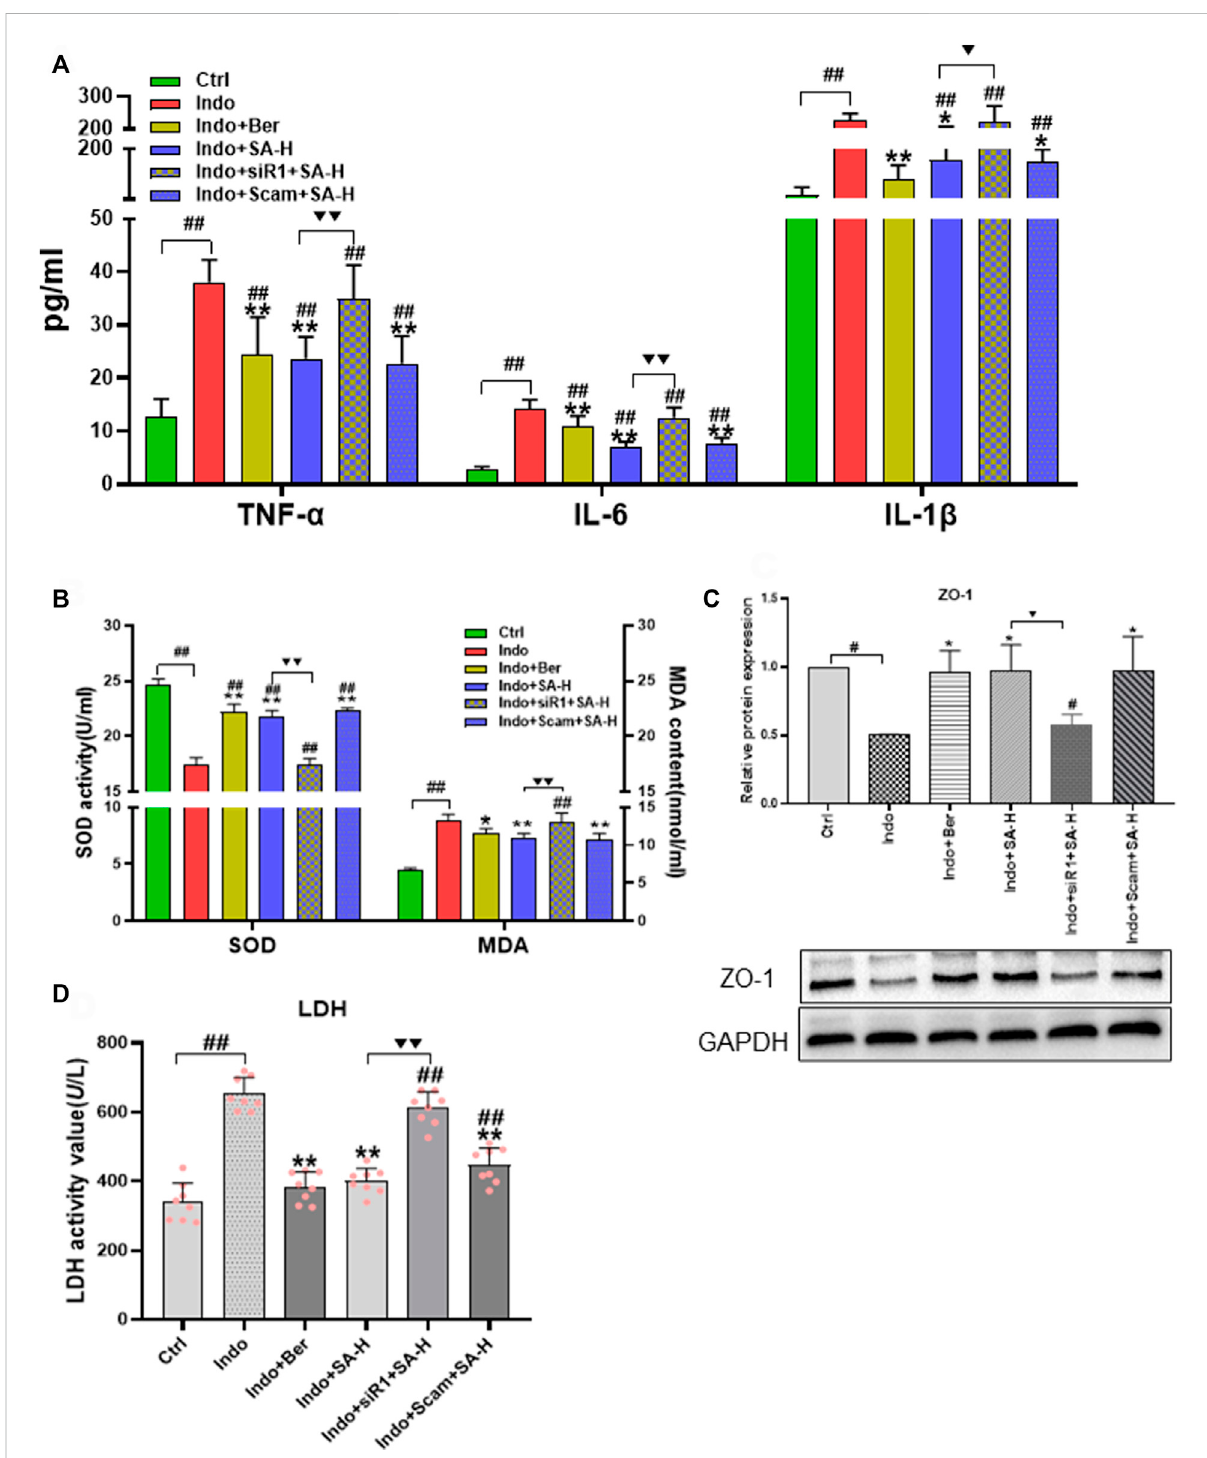
FIGURE 9 EffectsofNrf2silencingontheexpressionofZO-1,levelsofLDH,in fl ammatoryfactors,SODactivityandMDAcontentofIEC-6cellsinducedby indomethacin. IEC-6 cells were treated with indomethacin (Indo, 300 μ mol L − 1 ) and/or sanguinarine (SA, 1.0 μ mol L − 1 , SA-H) or with berberine (Ber, 30 mmol L − 1 ). (A) In fl ammatorycytokines.TNF- α ( left ),IL-6( middle ),andIL-1 β ( right )weremeasuredbyELISA( n =9). (B) Oxidativestressparameters of MDA and SOD were detected using a colorimetric assay kit and a chemiluminescent assay kit, respectively ( n = 6). (C) Protein levels of ZO-1 evaluated bywestern blot( n =3). (D) LDH releasedfrom theIEC-6cells, measuredbychemiluminescence ( n =8).Data are presented asthemean ± SD. # p < 0.05 and ## p < 0.01 vs. control (Ctrl). * p < 0.05 and ** p < 0.01 vs. indomethacin (Indo). ▼ p < 0.05 and ▼▼ p < 0.01 vs.